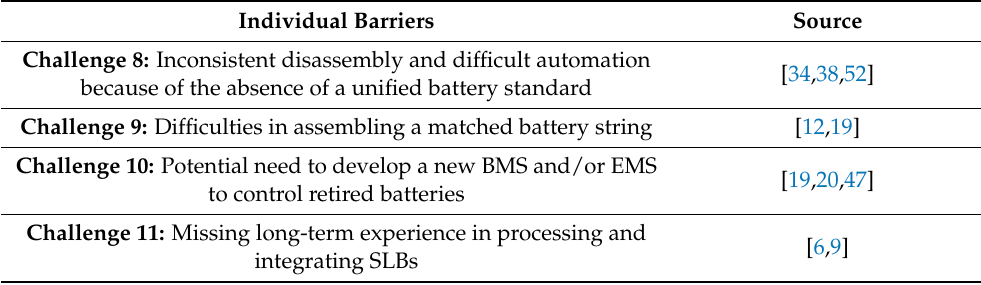
Table 3. The main barriers regarding Dismantling and Processing.